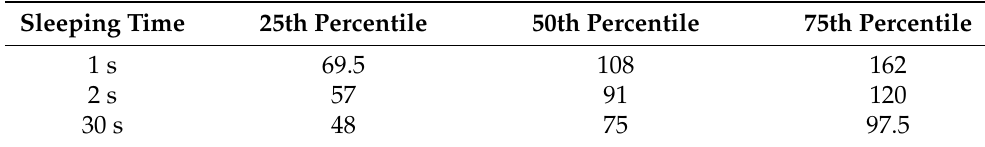
Figure 8. Representation of configuration time T C , varying the number of agents subscribed to configuration messages M and the sleeping time between status updates of the N nodes. Table 2. 25th percentile, median and 75th percentile of results for the second experiment Sleeping